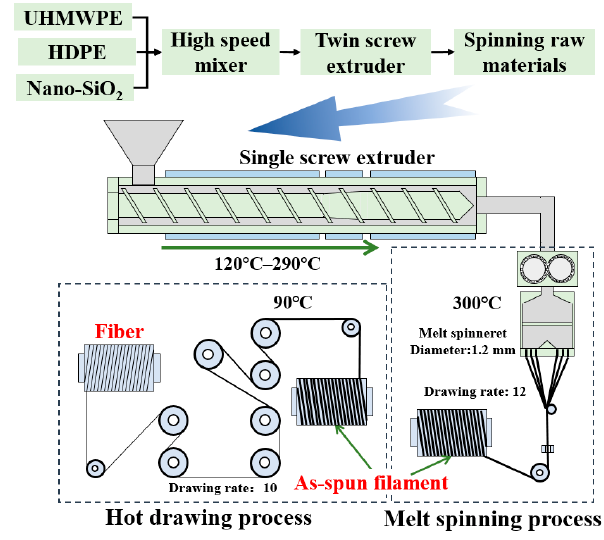
Figure 2. Preparation procedures of UHMWPE/HDPE/nano-SiO 2 blend fiber.